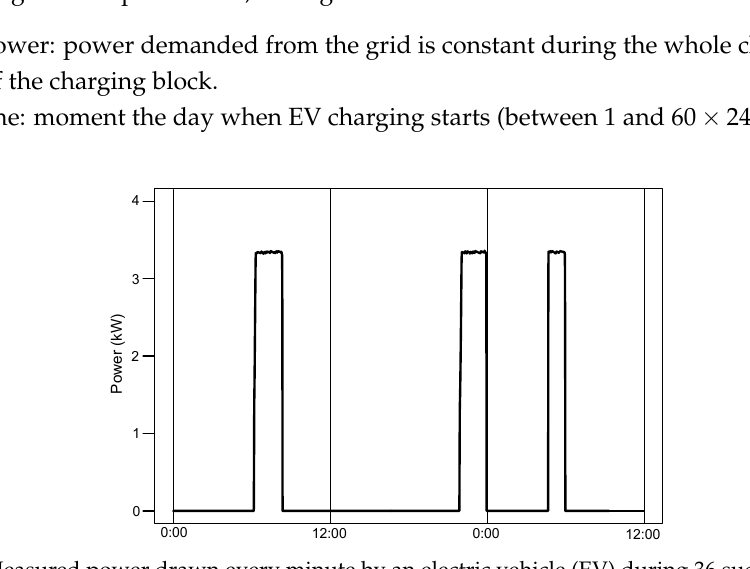
Figure 2. Measured power drawn every minute by an electric vehicle (EV) during 36 successive hours. Power is null when the EV is not charging, and close to a nominal power when